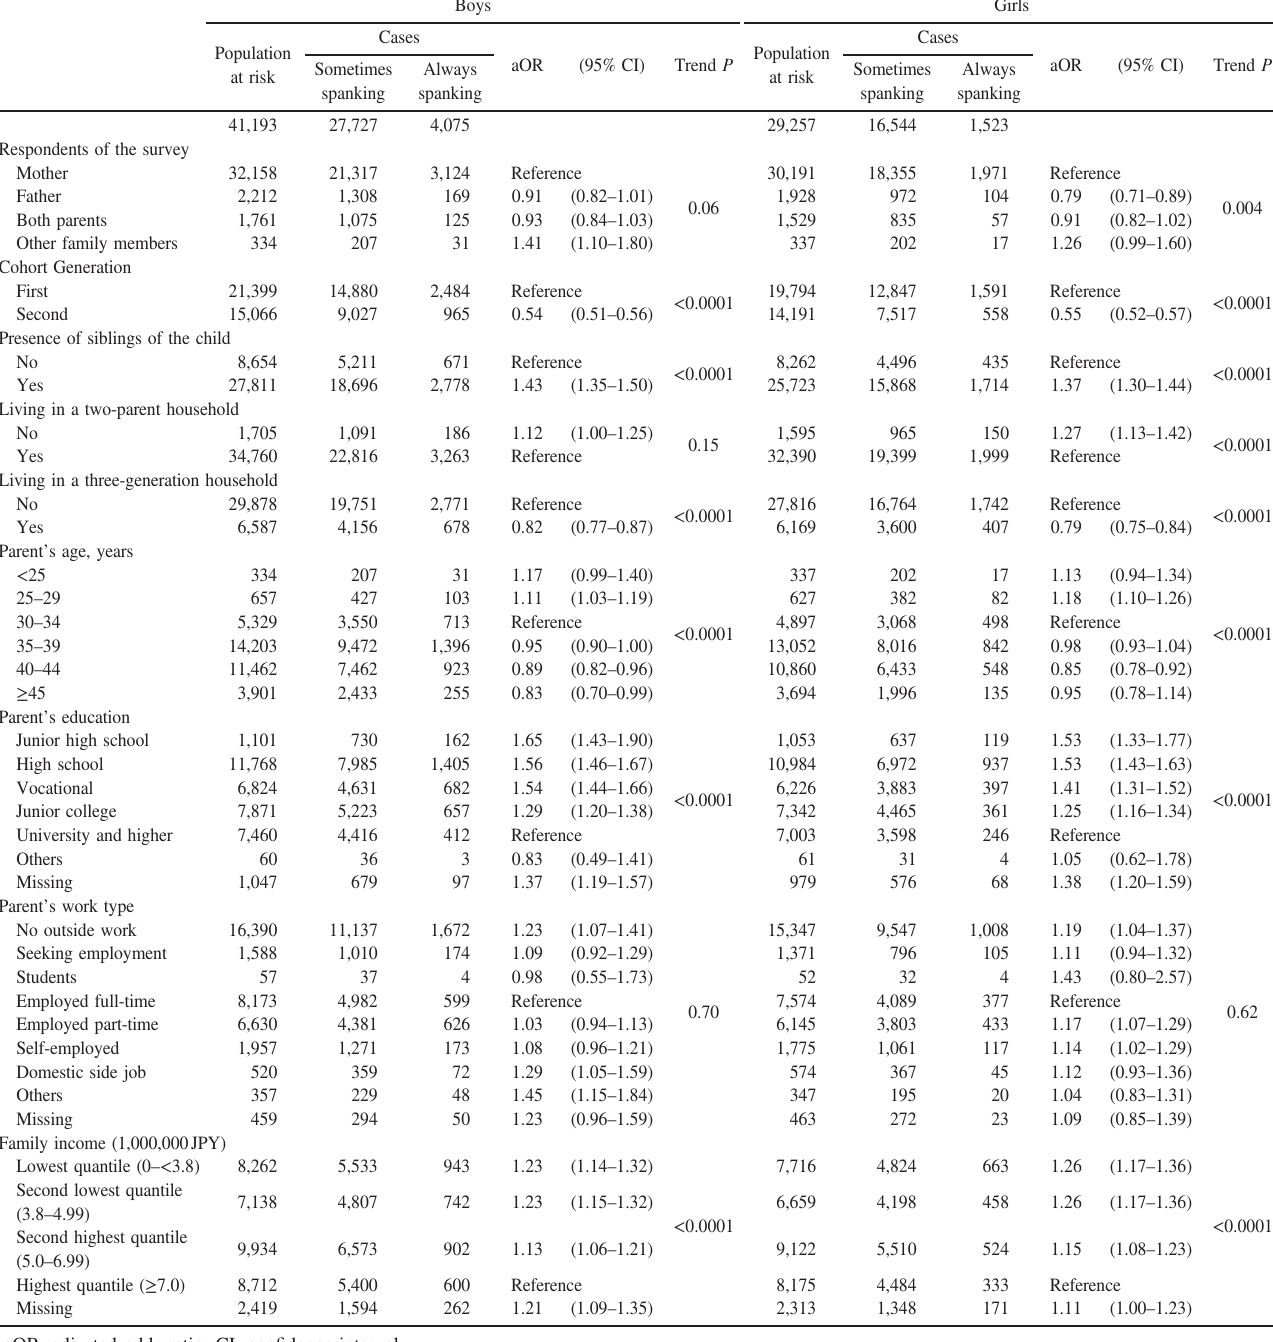
Table 5. Adjusted a odds ratios for spanking strati fi ed by gender of the child Boys